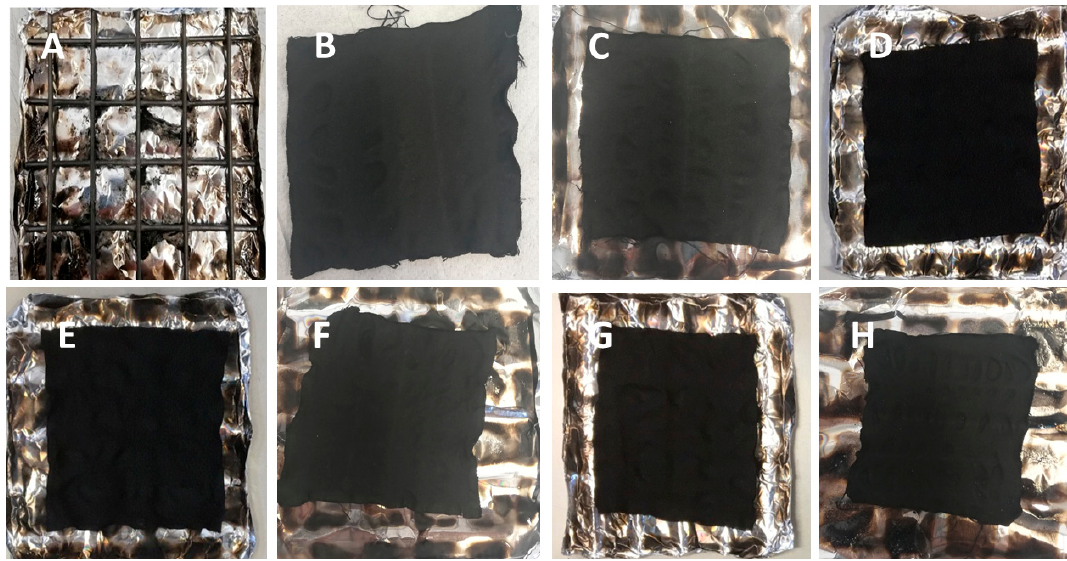
Figure 8. Residues of COT (A), COT+PA+BC(10) (B), COT+PA+BC(8) (C), COT+PA+BC(6) (D) and COT+PA+BC(4) (E) after cone calorimetry tests performed at 35 kW/m 2 . Residues of COT+PA+BC(10) (E), COT+PA+BC(8) (F) and COT+PA+BC(6) (H) after cone calorimetry tests performed at 50 kW/m 2 .